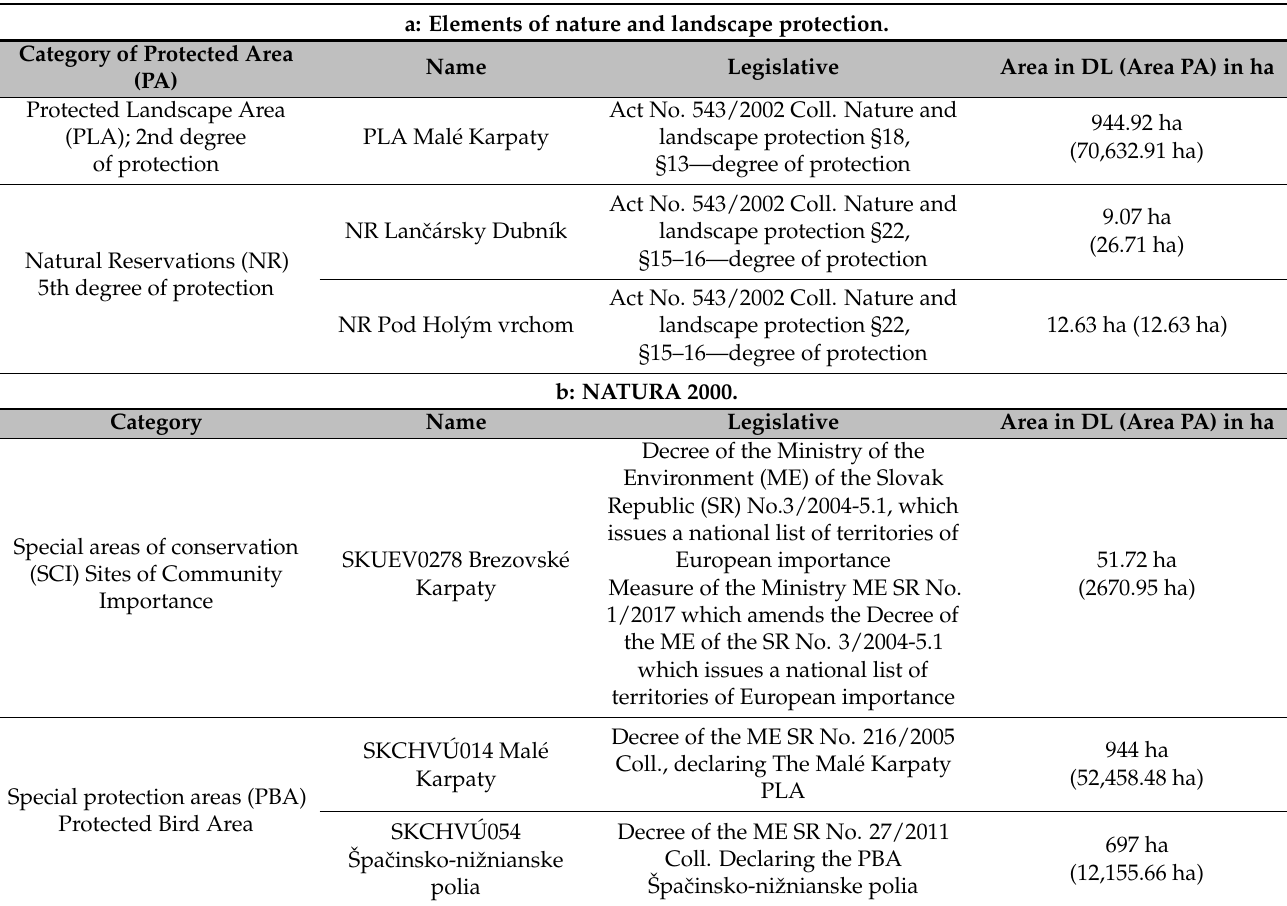
Table 1. ( a – h ) lists the Doln ý Lopašov positive socio-economic elements. a: Elements of nature and landscape